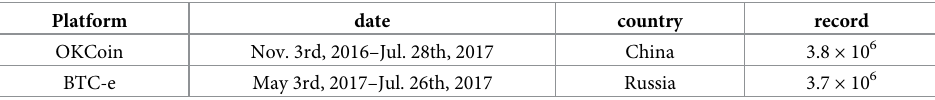
Table 1. The basis information about the OKCoin and BTC-e dataset.